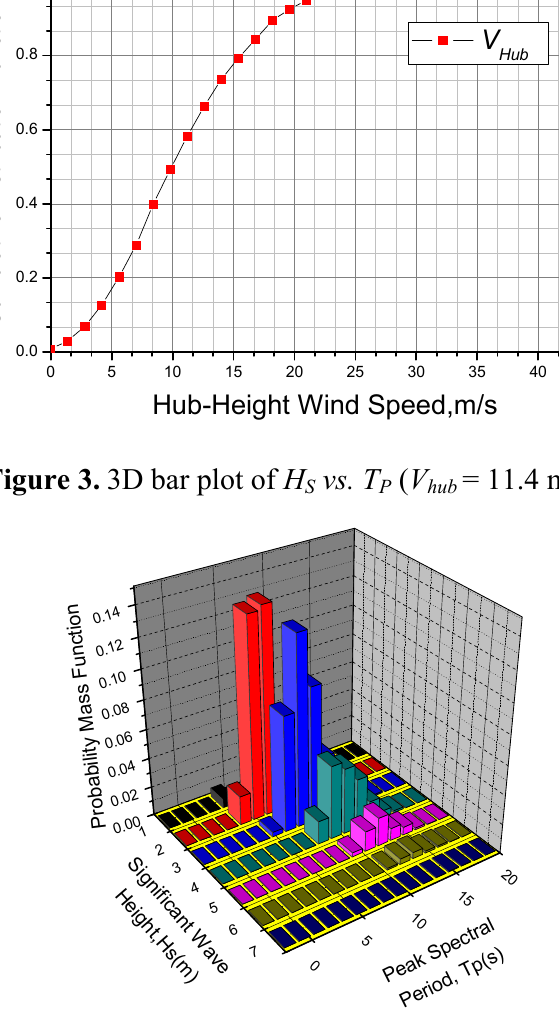
Figure 2. Cumulative distribution function of mean wind speed at the hub height.